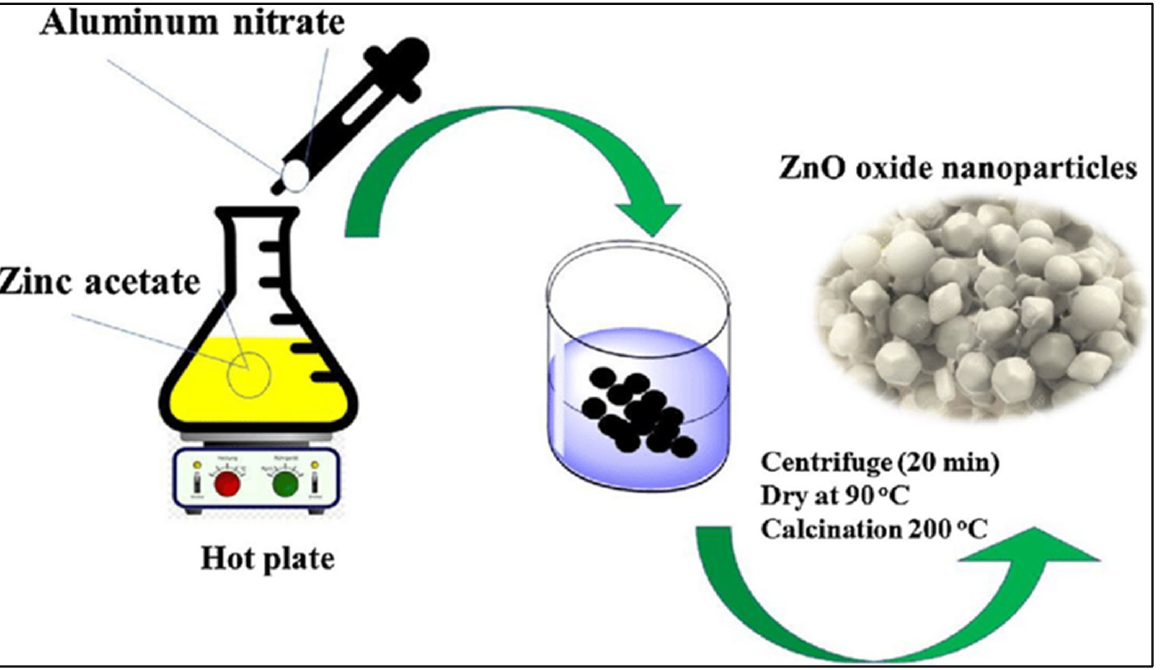
Figure 7. Preparation of zinc oxide (ZnO) nanoparticles by sol-gel method employing zinc acetate and aluminium nitrate as precursors [155].